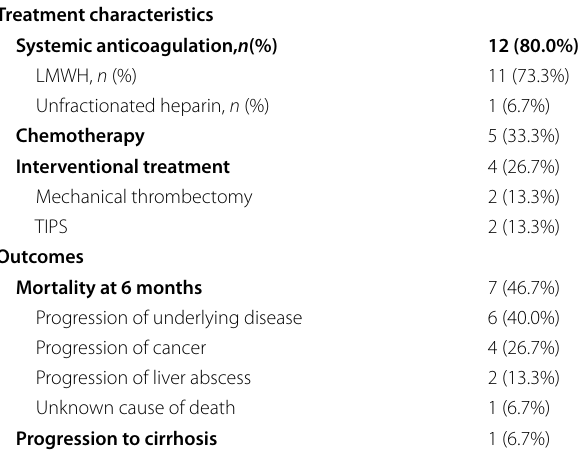
Table 2 Therapeutic and prognosis